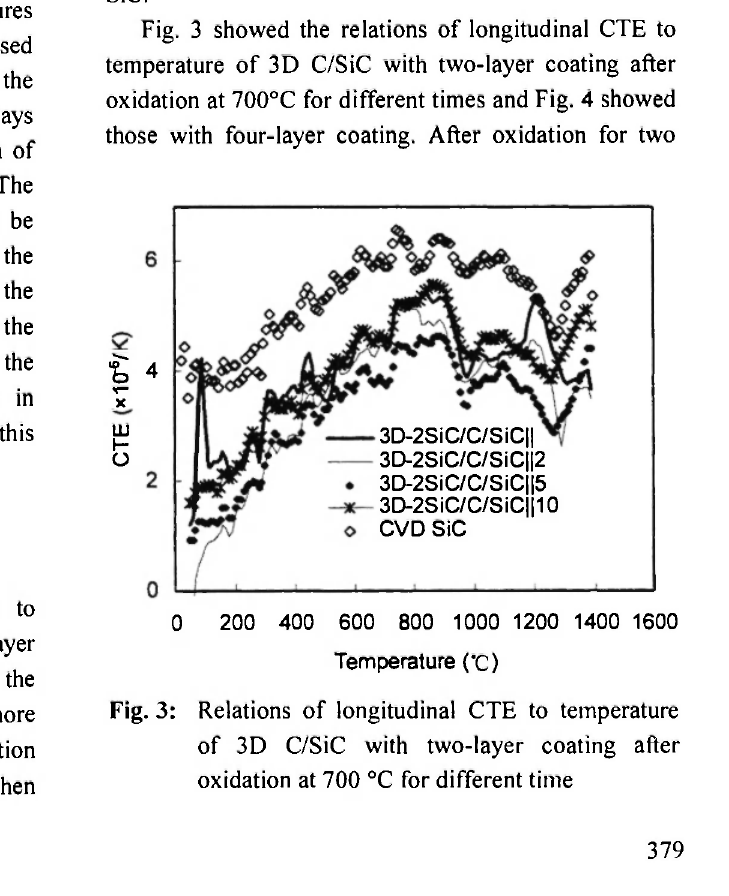
Fig. 2: Relations of weight loss to oxidation time of 3D C/SiC with different coating in air at 700°C